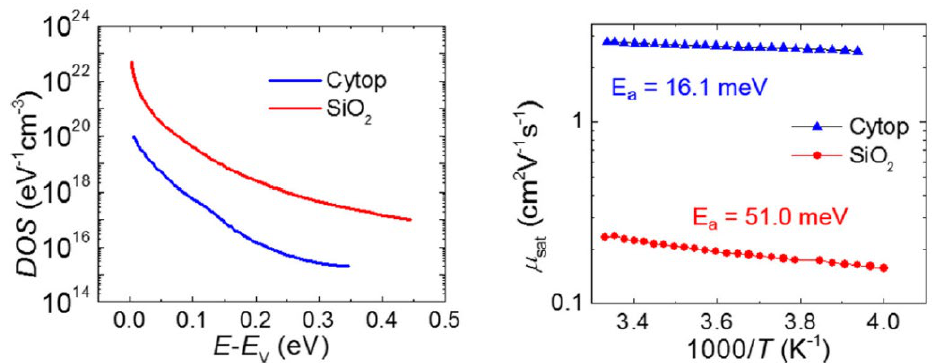
Figure 7. ( Left ) Trap DoS in diF-TES ADT OFETs with Cytop and SiO 2 dielectrics. ( Right ) Arrhenius plots for both Cytop and SiO 2. Reproduced with permission [59]. Copyright © 2015, AIP Publishing.